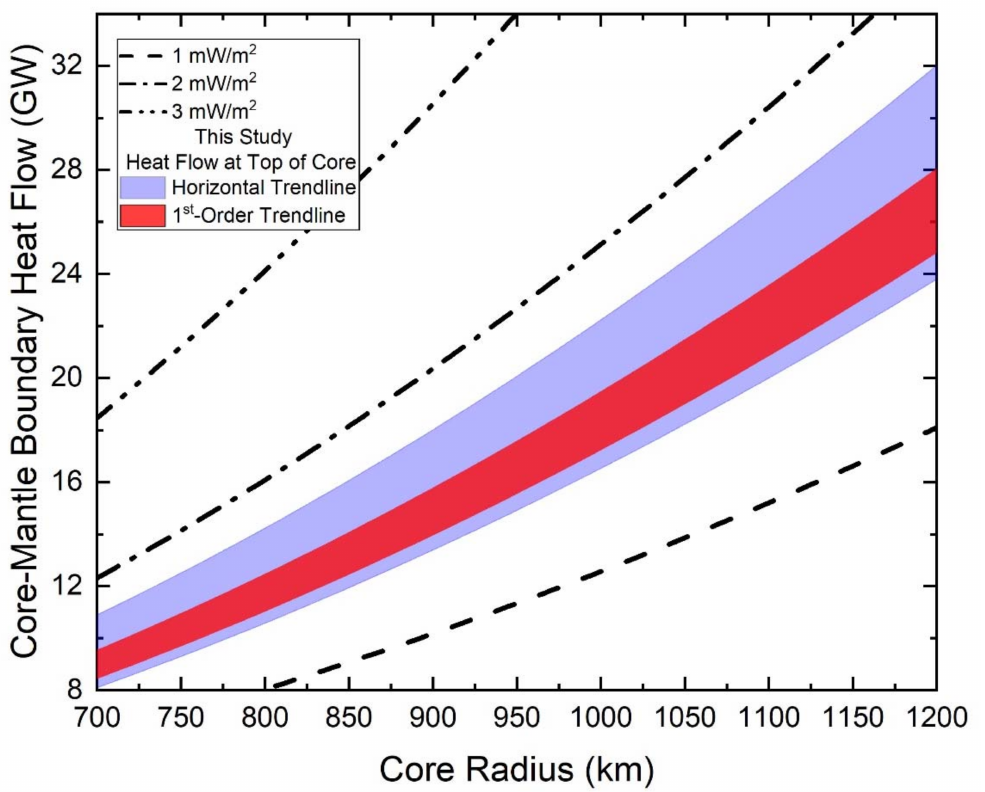
Figure 4. Calculated adiabatic heat flow at the core–mantle boundary (CMB) of Ganymede of a fully molten eutectic-adjacent core at 5 GPa. The differently dashed lines each represent different estimates of the heat flow through the CMB [3–5,10]. The shaded regions represent all values of calculated heat flow values on the core-side of the CMB. The lighter blue and darker red shaded regions are calculated values using a horizontal and linear fitting trendline, as shown in the Supporting Information section. The CMB temperature ranges from 1250 K at the bottom to 1450 K at the top of the shaded regions of this study. Propagated uncertainty for the calculations ranges from ~1 to 1.5% of the reported